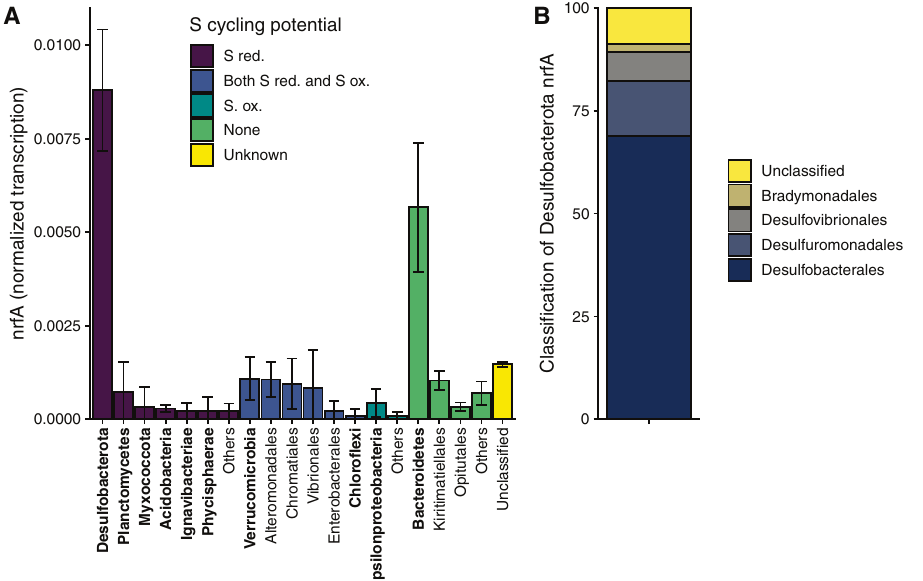
Fig. 6 Transcription of nrfA, a key marker gene for DNRA in surface sediments at the sampling site A assignment of nrfA transcripts to phylum (bold), or order level. The colors indicate the potential of these classes to carry out sulfur metabolism as identi fi ed from literature surveys. Transcript abundance was normalized by gene length and against the total abundance of rpoB in the metatranscriptome. B Assignment of Desulfobacterota nrfA transcripts to order level, as a percentage of total nrfA transcripts assigned to Desulfobacterota. In both panels averages are shown from three individual metatranscriptomes and error bars are standard deviation. These samples were sequenced in